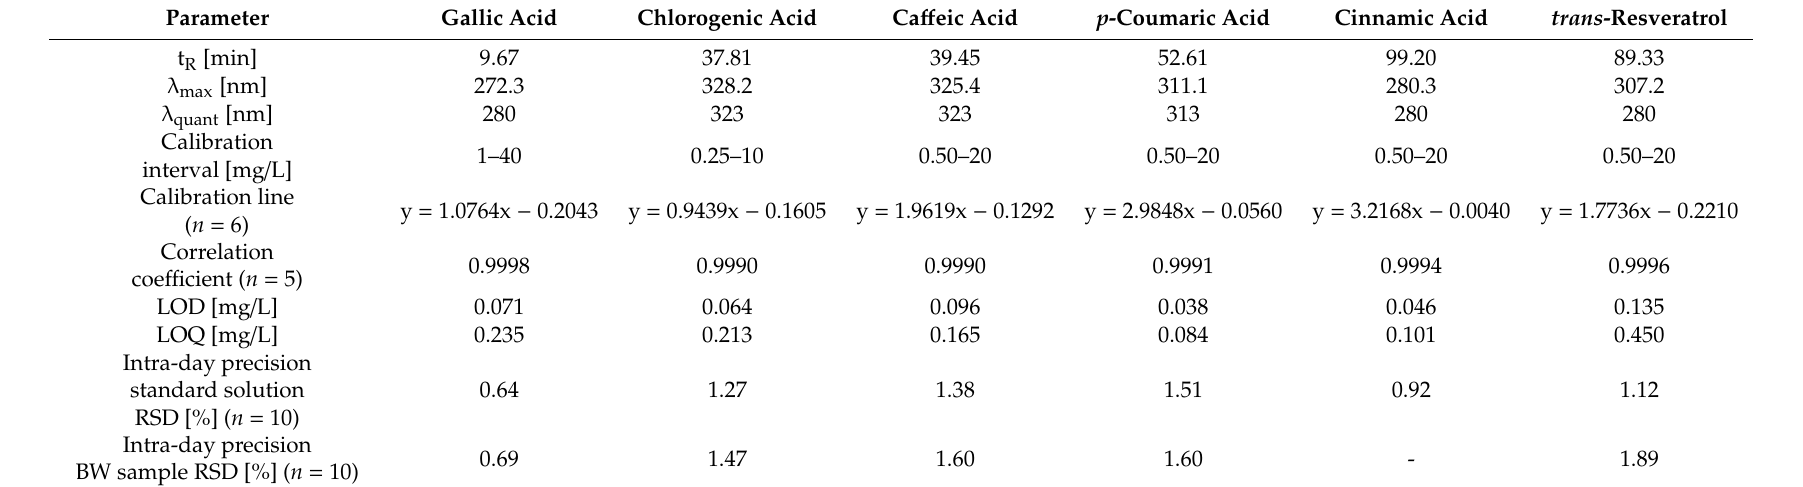
Table 1. HPLC method validation parameters for the determination of six individual phenolic compounds in blackberry